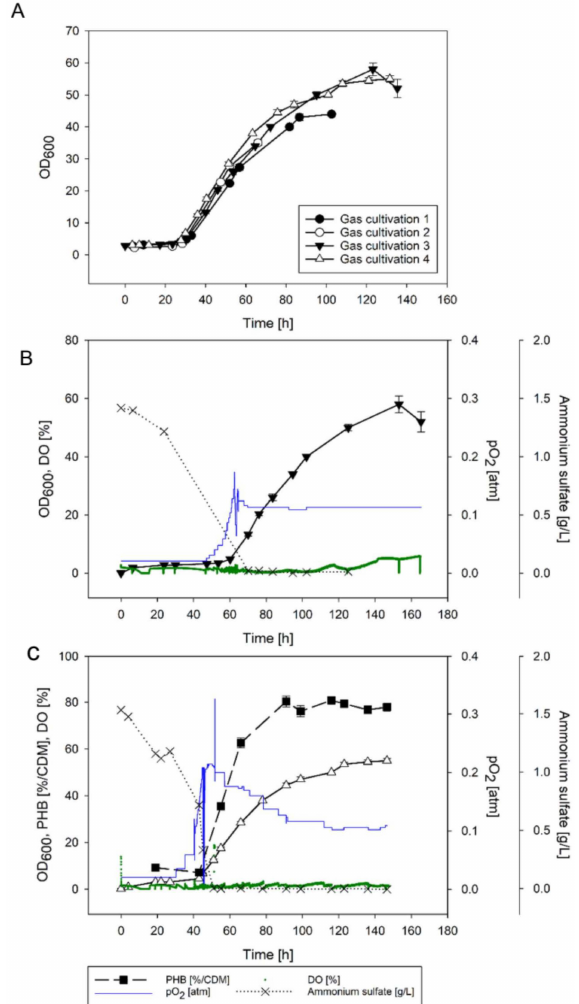
Figure 7. Time curves of gas cultivations with manual DO control using a dipping probe. Panel ( A ) indicates OD 600 values over time of all four gas cultivations (starting points of gas cultivations in panel A were normalized to the start of CO 2 assimilation). Panels ( B , C ) indicate gas cultivations 3 and 4, respectively (triangles indicate OD 600 values from Figure 7A, p O2 blue line, DO in % (100% corresponds to full saturation with pure oxygen) illustrated as green dots, ammonium black crosses, PHB in % per CDM black squares). All data of gas cultivations are summarized in the Supplementary Data and the Supporting Information Figure